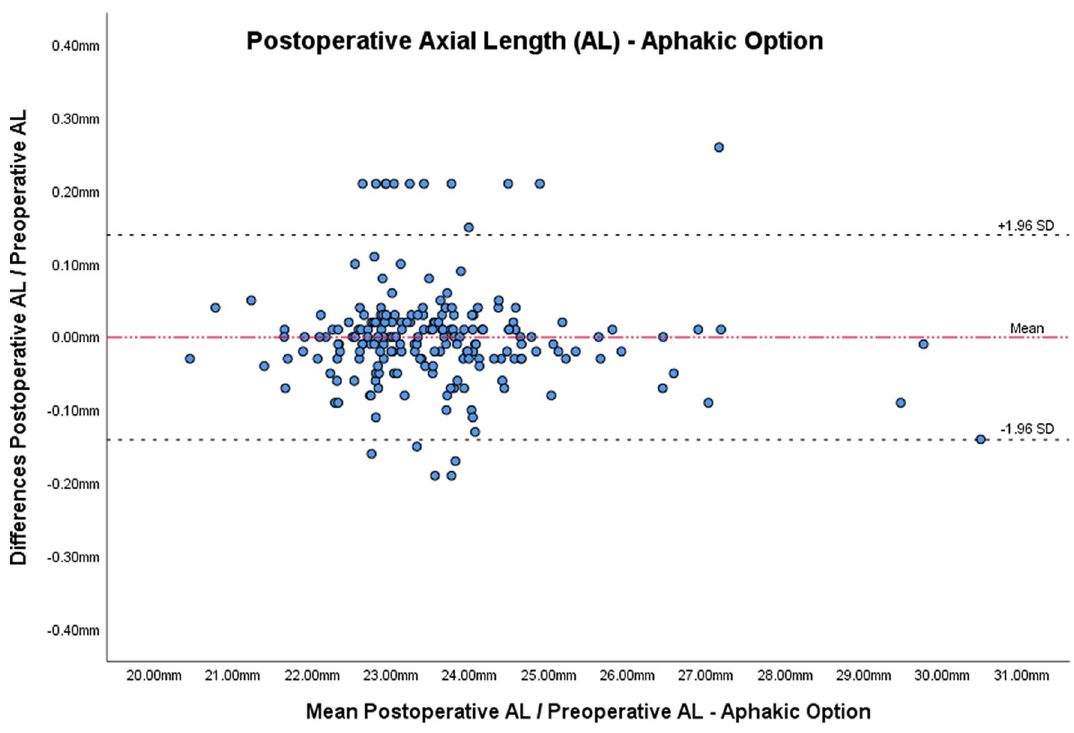
Figure 2. Bland–Altman plot of axial length measured before and after cataract surgery utilizing the aphakic option.